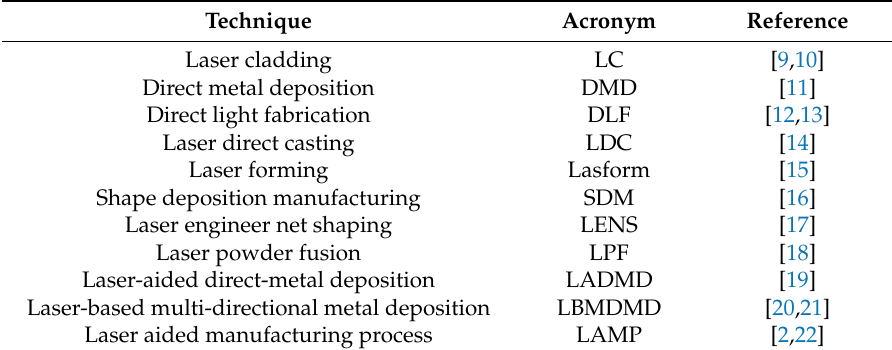
Table 1. Various commercialized directed energy deposition (DED) processes.